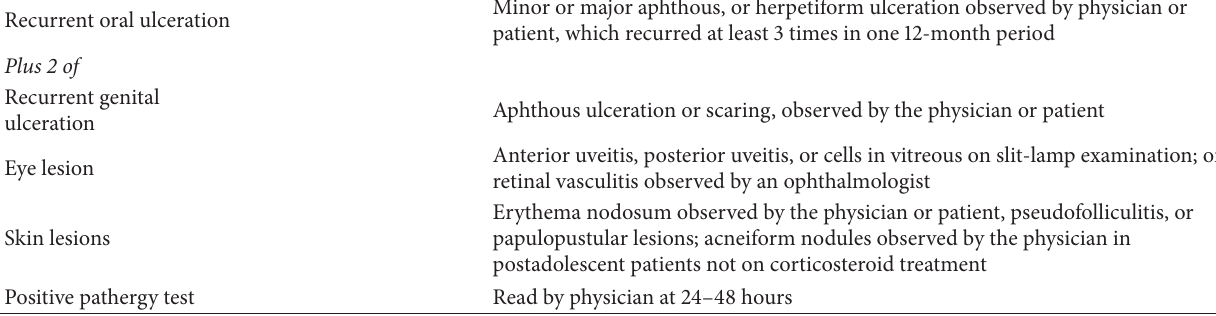
Table 3: The International Study Group criteria for Behcet’s Disease [16].